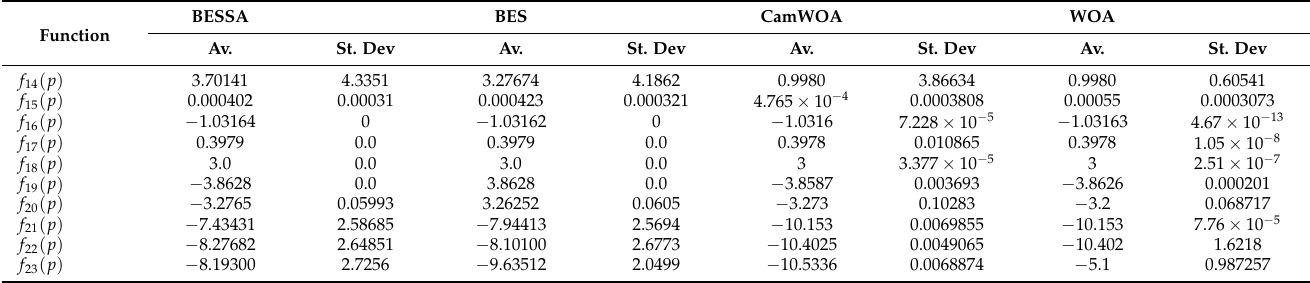
Table 6. Statistical outcomes of fixed dimensional multimodal benchmark test